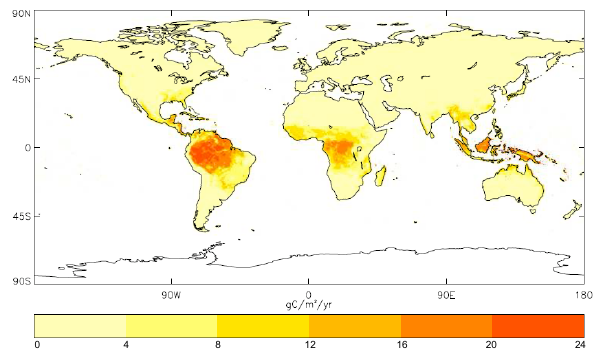
Fig. 9. Annual global simulation of isoprene emissions averaged over the